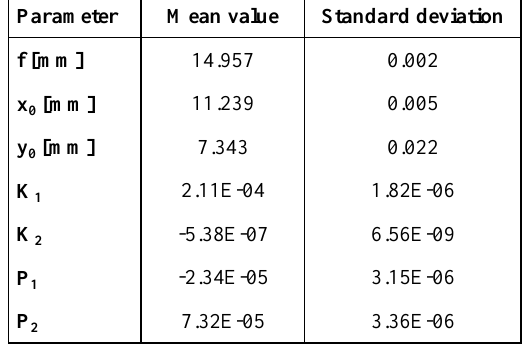
Table 1. The results of Sony NEX 5R calibration (Image